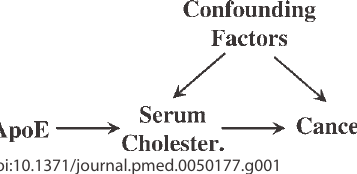
Figure 1. The ApoE Genotype as an Instrumental Variable in a Mendelian Randomisation